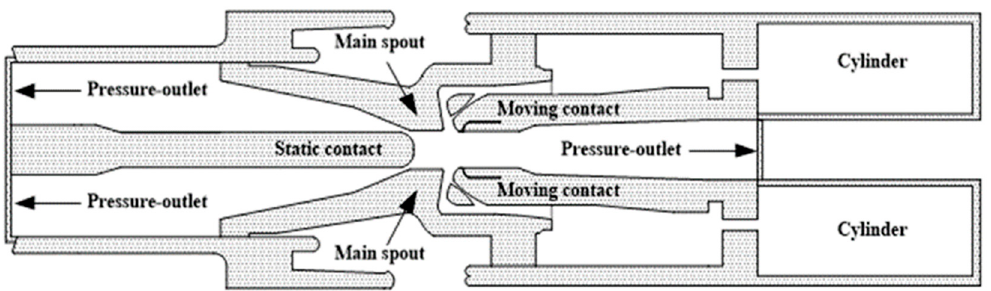
Figure 1. Geometric model of 40.5 kV circuit breaker. Table 2. Boundary condition.